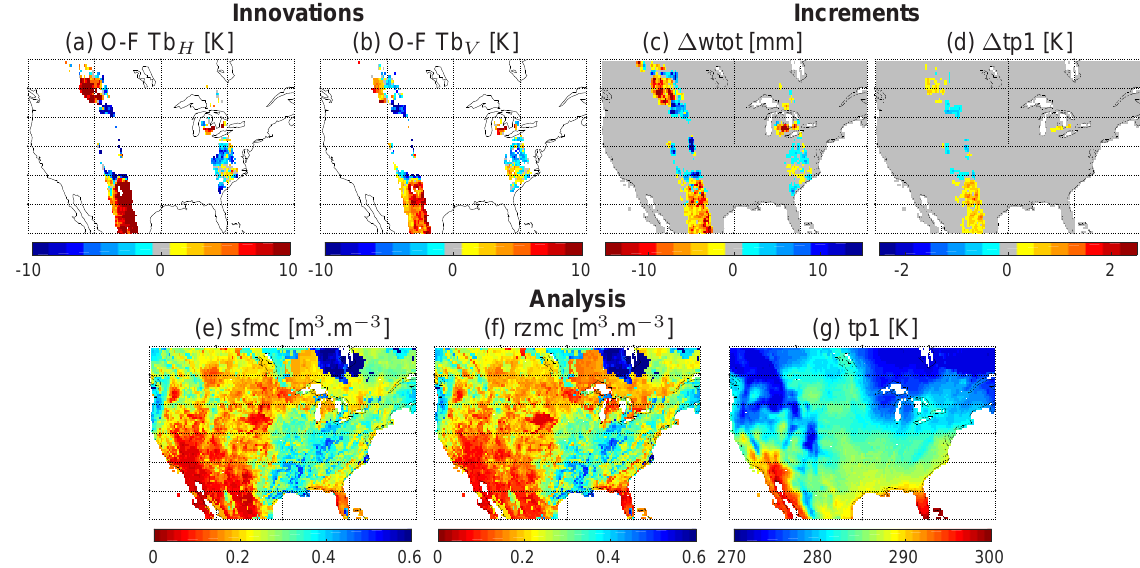
Figure 2. Soil moisture and temperature analysis on 30 April 2015 at 12:00 UTC for the Tb_fit assimilation system. ( a , b ) Tb innovations (O–F) at a 40 ◦ incidence angle for H - and V -polarization respectively; ( c , d ) increments in total profile water ( (cid:49) wtot) and first soil layer temperature ( (cid:49) tp1), respectively; ( e , f , g ) assimilation analyses of surface soil moisture (sfmc), root-zone soil moisture (rzmc), and soil temperature (tp1), respectively.